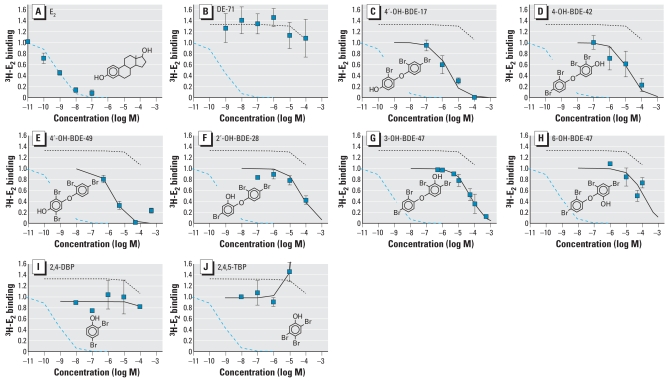
Displacement of 1 nM 3H-E2 from recombinant ER-α in vitro by E2 (A), DE-71 (B), and the OH-BDEs 4′-OH-BDE-17 (C), 4-OH-BDE-42 (D), 4′-OH-BDE-49 (E), 2′-OH-BDE-28 (F), 3-OH-BDE-47 (G), 6-OH-BDE-47 (H), 2, 4-DBP (I), and 2, 4, 5-TBP (J) found in mice (by the ER-α binding assay). Each curve for an OH-BDE represents the mean of 3–4 independent dose–response studies, except for 4-OH-BDE-49, 6-OH-BDE-47, and the bromophenols only 2 assays were performed. Curves for DE-71 and E2 are the mean of 6 and 11 independent dose–response studies, respectively. Error bars indicate SE. All values are normalized to vehicle control (DMSO = 1). Modeled data for E2 (dashed blue line) and DE-71 (dotted line) are shown in all OH-BDE charts for comparison. Modeled data for each OH-BDE are shown as a solid line.